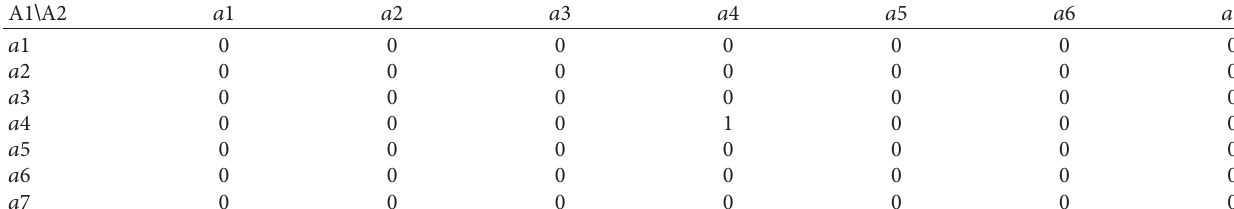
Table 6: Calculated optimal mix strategy of “A”: stage